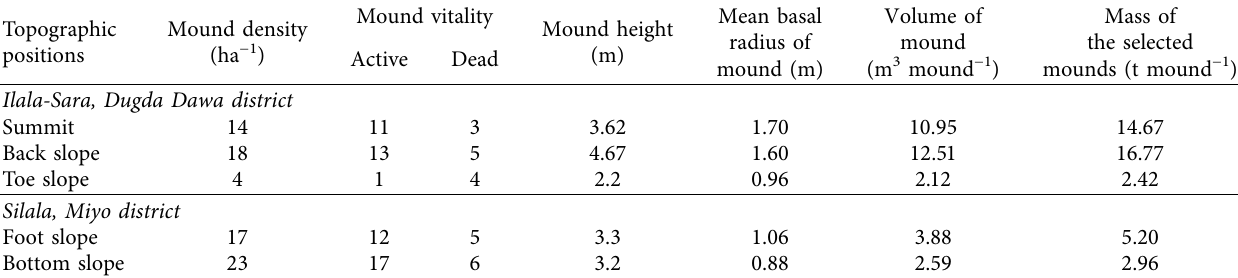
Table 2: Te characteristics of termite mounds vary across toposequence in Ilala-Sara and Silala, southeast Ethiopia. Topographic Mound positions